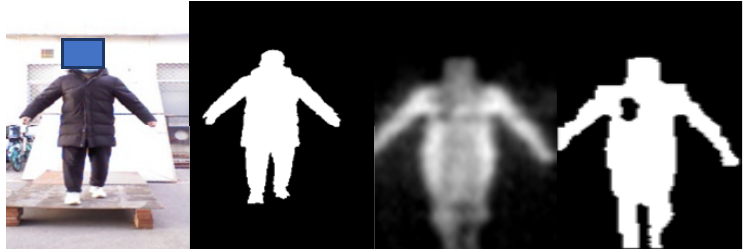
Figure 10. Example of segmentation dataset, including the paired VI and PMMWI, and the corre- sponding segmentation label.